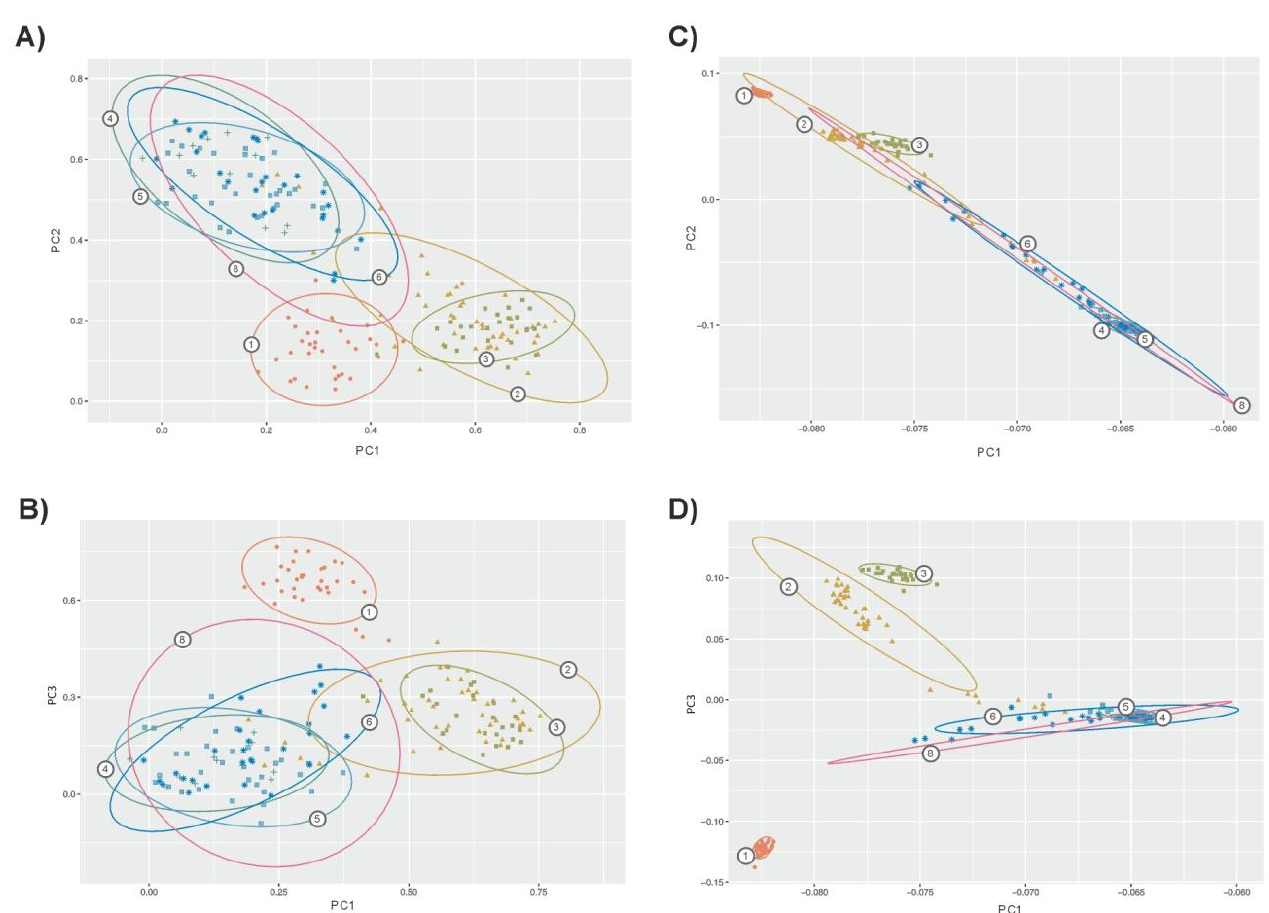
Figure 3. Bidimensional plots illustrating dispersion of the cattle individuals sampled according to the three first factors computed via PCA on microsatellite data (Plots A , B ) and SNPs (Plots C , D ). Plots A and C wereconstructed using Factors 1 (on X -axis) and 2; Plots B and D wereconstructed using Factors 1 (on X -axis) and 3. Contour plots illustrate the 75% confidence region of the relationships betweenthe individuals assigned to each population. Numbers on contours mean the following: (1) Lagunaire; (2) N’Dama (Burkina Faso); (3) N’Dama (Congo); (4) Zebu Peul (Benin); (5) Zebu Peul (Burkina Faso); (6) Borgou; and(8) Zou. Populations from 1 to 3 belong to West African taurine cattle, populations 4 and 6 belong to West African zebu cattle and populations 6 and 8 belong to sanga cattle. Confidence intervals for the two Lobi individuals were not computed.